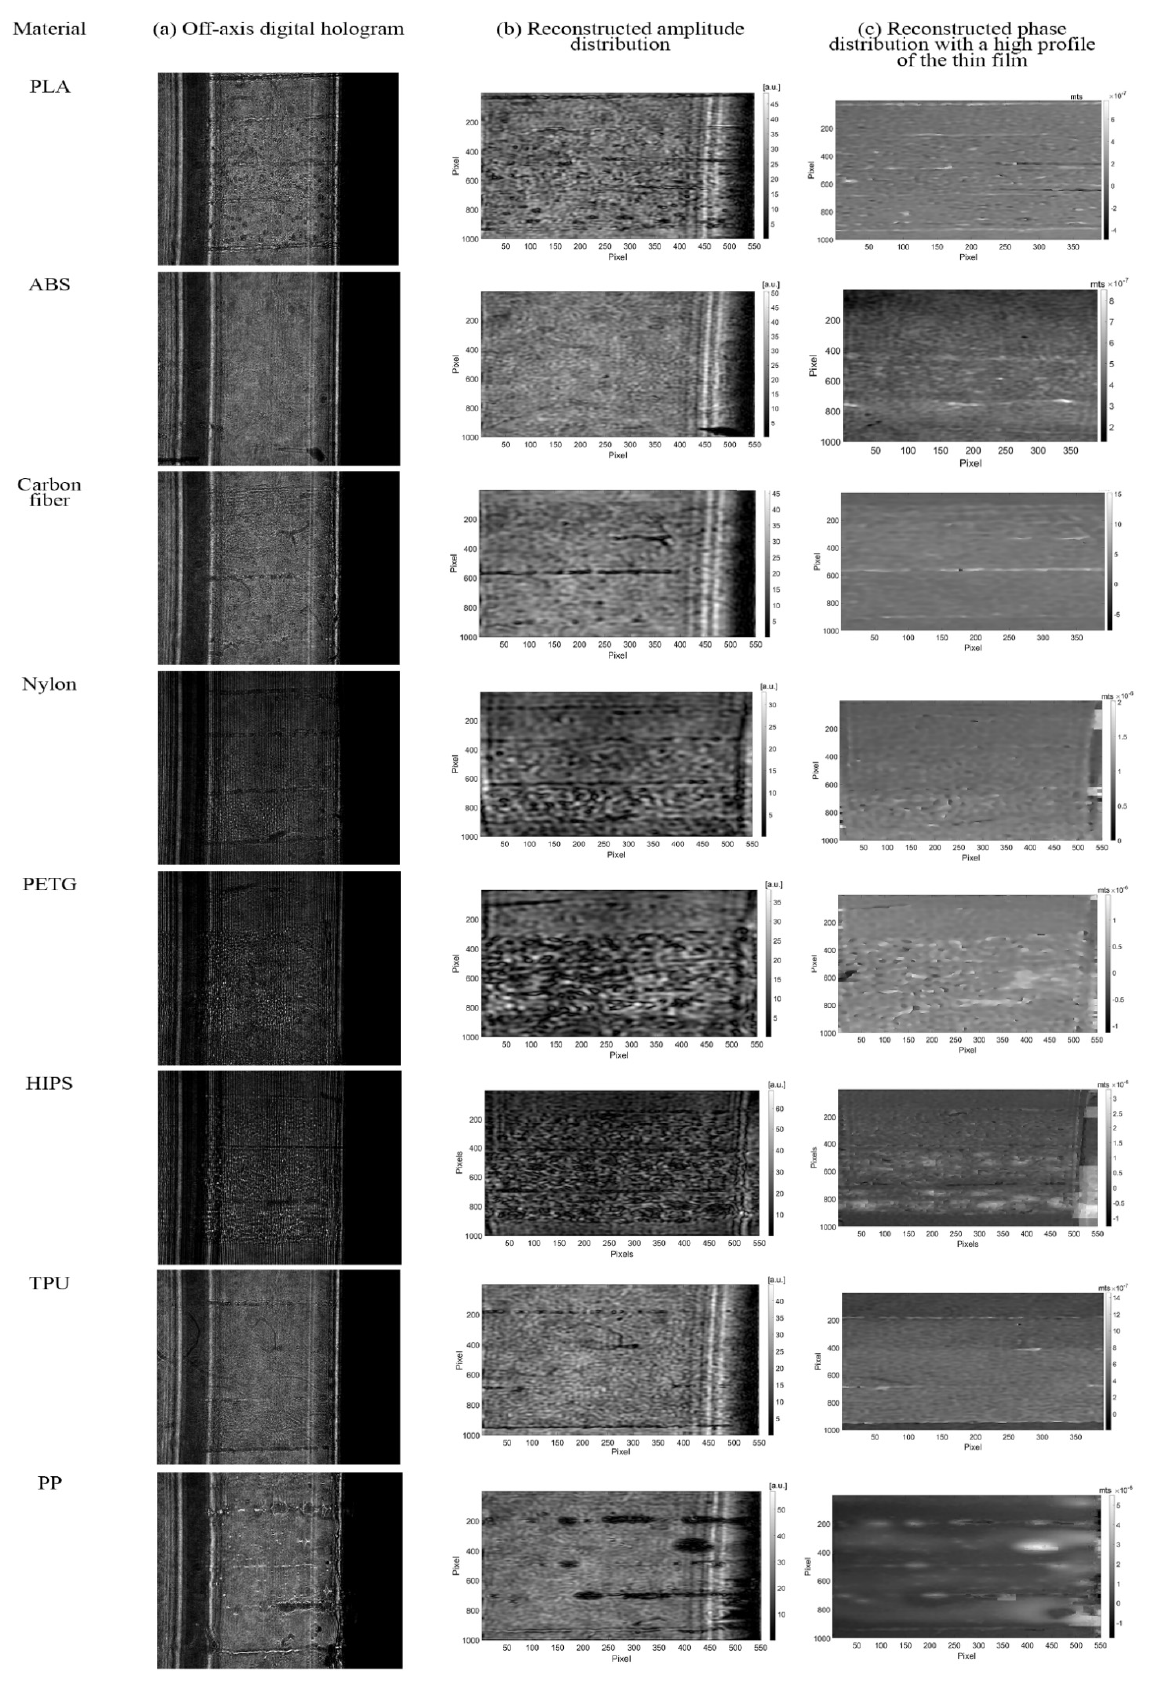
Figure 8. Reconstruction of thermoplastics filaments deposition nanoparticles by